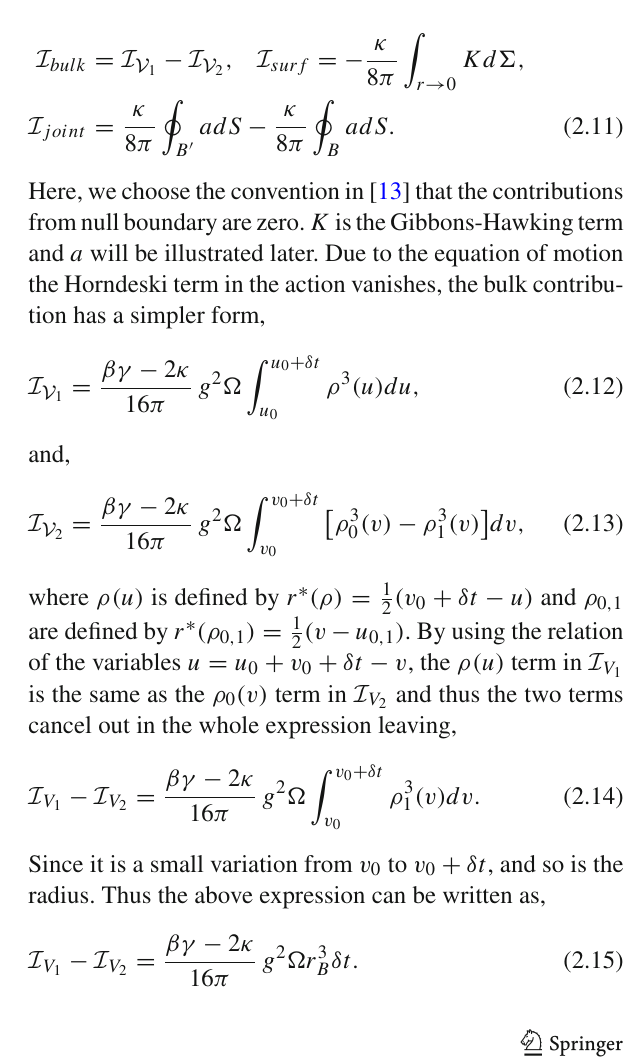
Fig. 1 Plots of WDW patches. The left panel shows the WDW patches at coordinate t 0 and t 0 + δ t , while the right panel shows the difference of the two